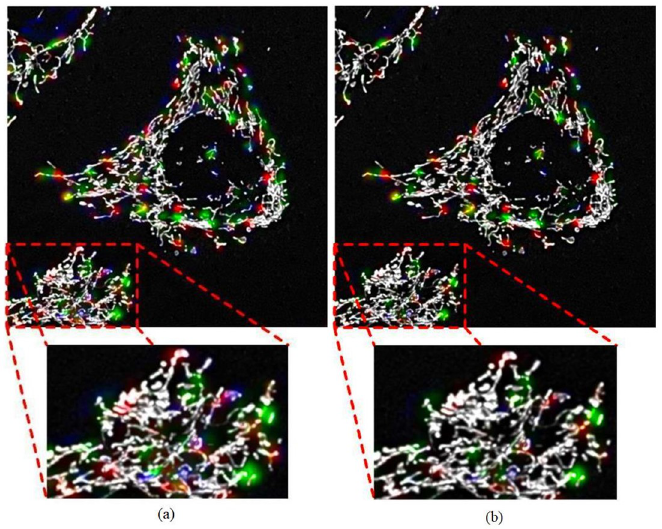
Fig 8. The output of the Vox2Vox GAN after training. (A) The output after training with the clean dataset for 514 epochs and (B) after training with the complete dataset for an additional 26 epochs to reduce noise artefacts. The reduction in random noise artefacts is illustrated within the enlarged view of the red rectangles, which was achieved by using the complete dataset for noise reduction training. More than 26 epochs of noise reduction training did not further improve the outputs of the generator. Some noise fragments remained, however, only the two predicted fusion events (green kernels) on the right of the enlarged z-stack were regarded as predicted events during validation.